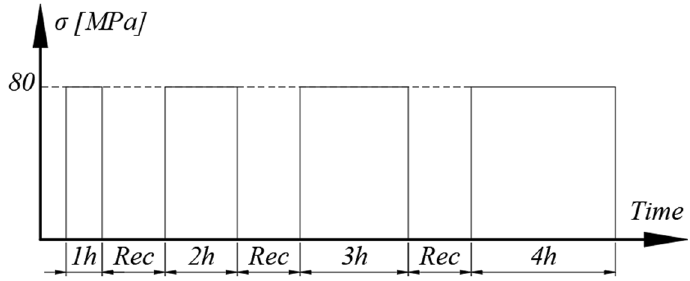
Figure 6. Creep-recovery with variable creep duration.